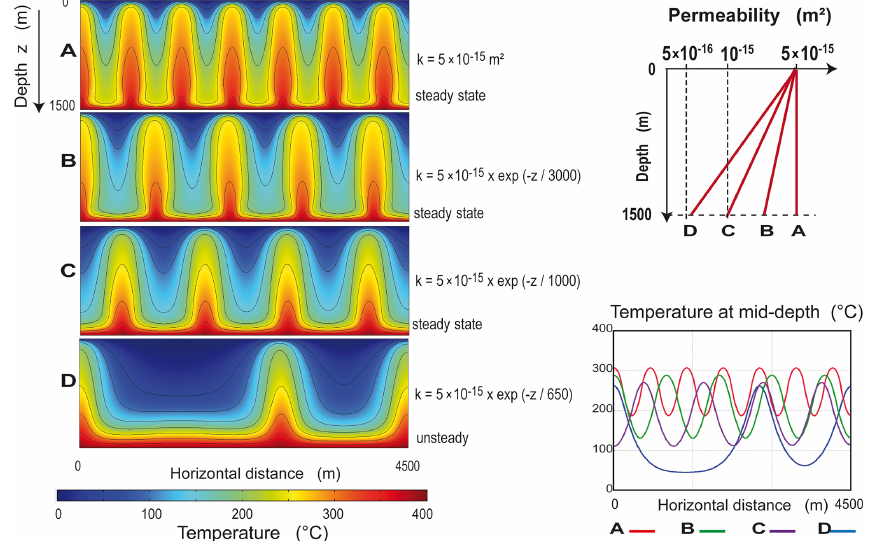
Figure 2. The effect of the depth dependence (decrease) of the permeability, here taken as exponential. The number of upwellings decreases when the depth dependence is accounted for: six internal upwellings are obtained for the constant permeability case (labeled A, top pattern) but only one for the steepest exponential decrease (D, bottom). Horizontal temperature profiles at mid-depth (bottom right) illustrate a major cooling effect, as well as the increasing temperature contrast between upwellings and downwellings when depth dependence is increased. See the text for